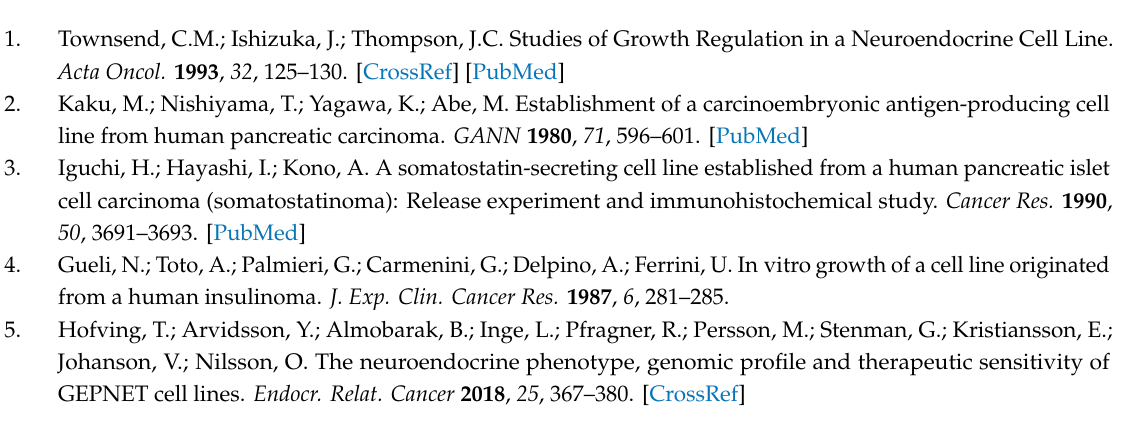
Table S1: List of all miRs identified in BON and QGP cells by NGS; Table S2: List of miRs identified in BON-1, QGP-1 and NT-3 cells and their functional activities; Table S3: Primers used for